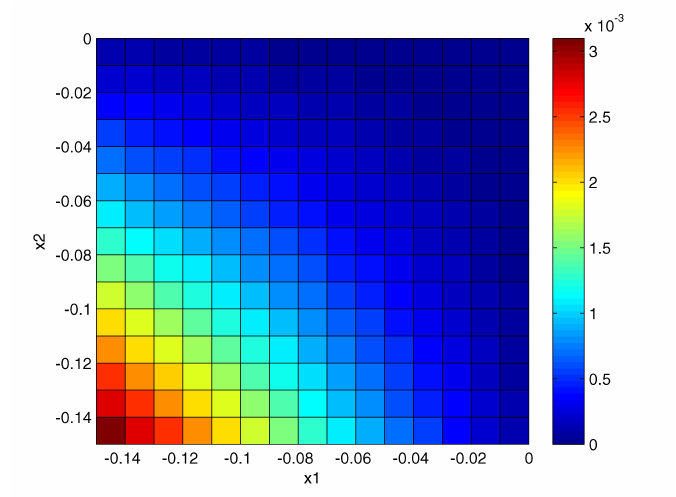
Figure 2. Approximation Error for Equation